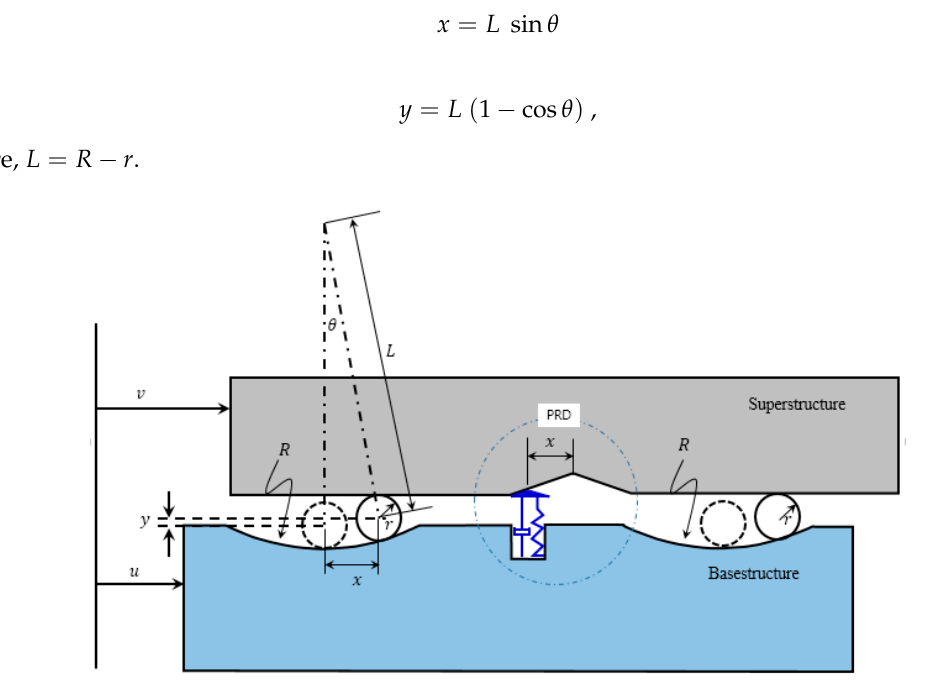
Figure 1. Model of rolling-type isolator with the position restoring device (PRD).